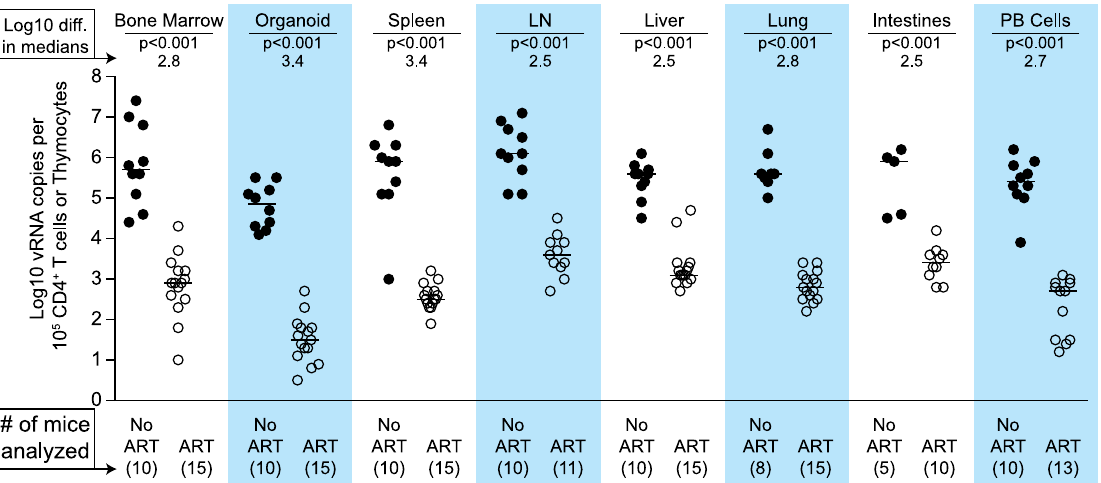
Figure 4. Each tissue analyzed exhibited a significant decline in vRNA during ART. When cell-associated vRNA levels during the plateau stage (treated 28–64 days) are compared to those from untreated mice, the reduction in vRNA levels were significant in all tissues (p , 0.001). Reductions in cell-associated vRNA levels are presented as log10 differences in medians. Mann-Whitney tests were used to generate p values. (Closed symbols=no ART; open symbols=ART).